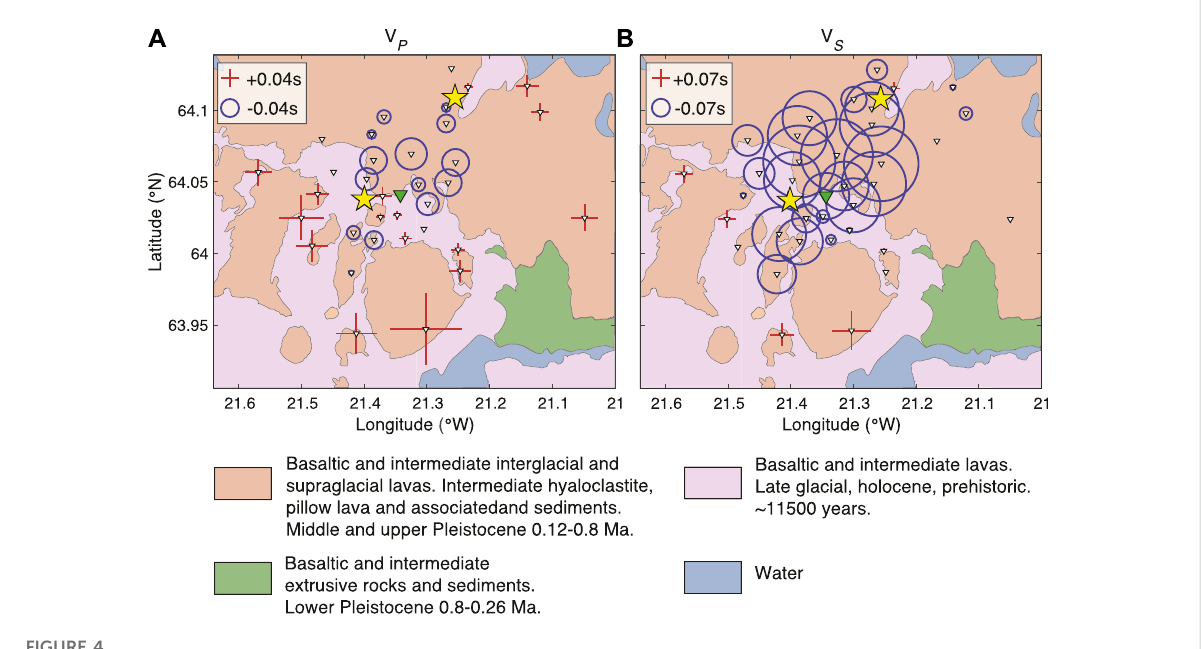
FIGURE 4 Station delays for (A) P- and (B) S-waves as obtained from the joint P+S inversion with VELEST. Red crosses indicate delayed arrival times with respect to the average 1-D model, while blue circles indicate earlier arrivals. The green triangle indicates the reference station (zero delay). The S delay is scaled by 1/1.75 (the inverse of theaverage Vp/Vs ratio). The geologicalmap in thebackgroundwas modi fi edfrom Sæmundsson et al.,